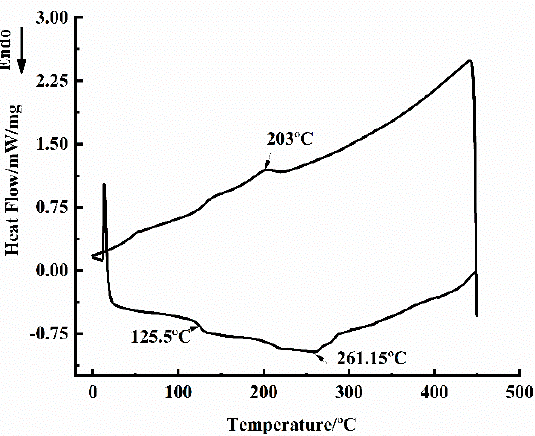
Figure 2. DSC analysis for self-prepared Graphene/PEKK composite powder.